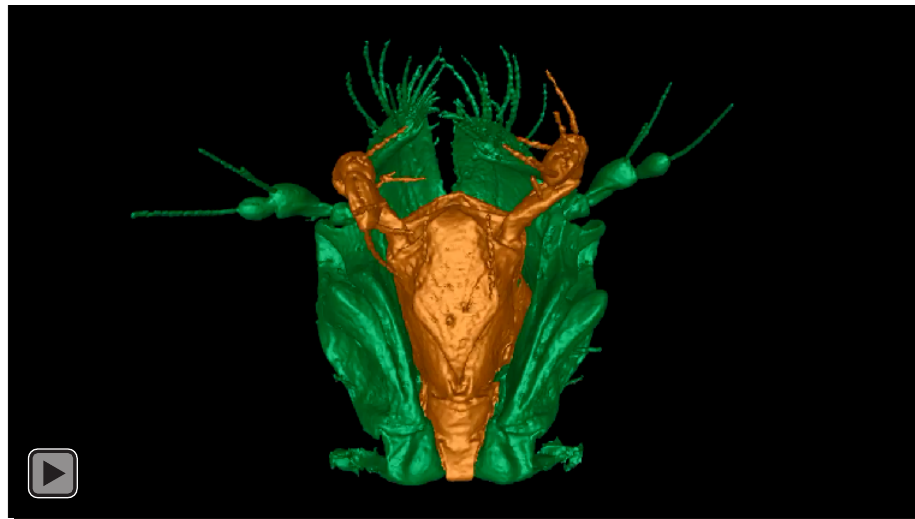
Video 4. 3D rotation video of segmented surface reconstructions of the mouthparts of Zasphinctus sarowiwai sp. n. (CASENT0764652) in open configuration (green= maxillae; yellow=labrum;